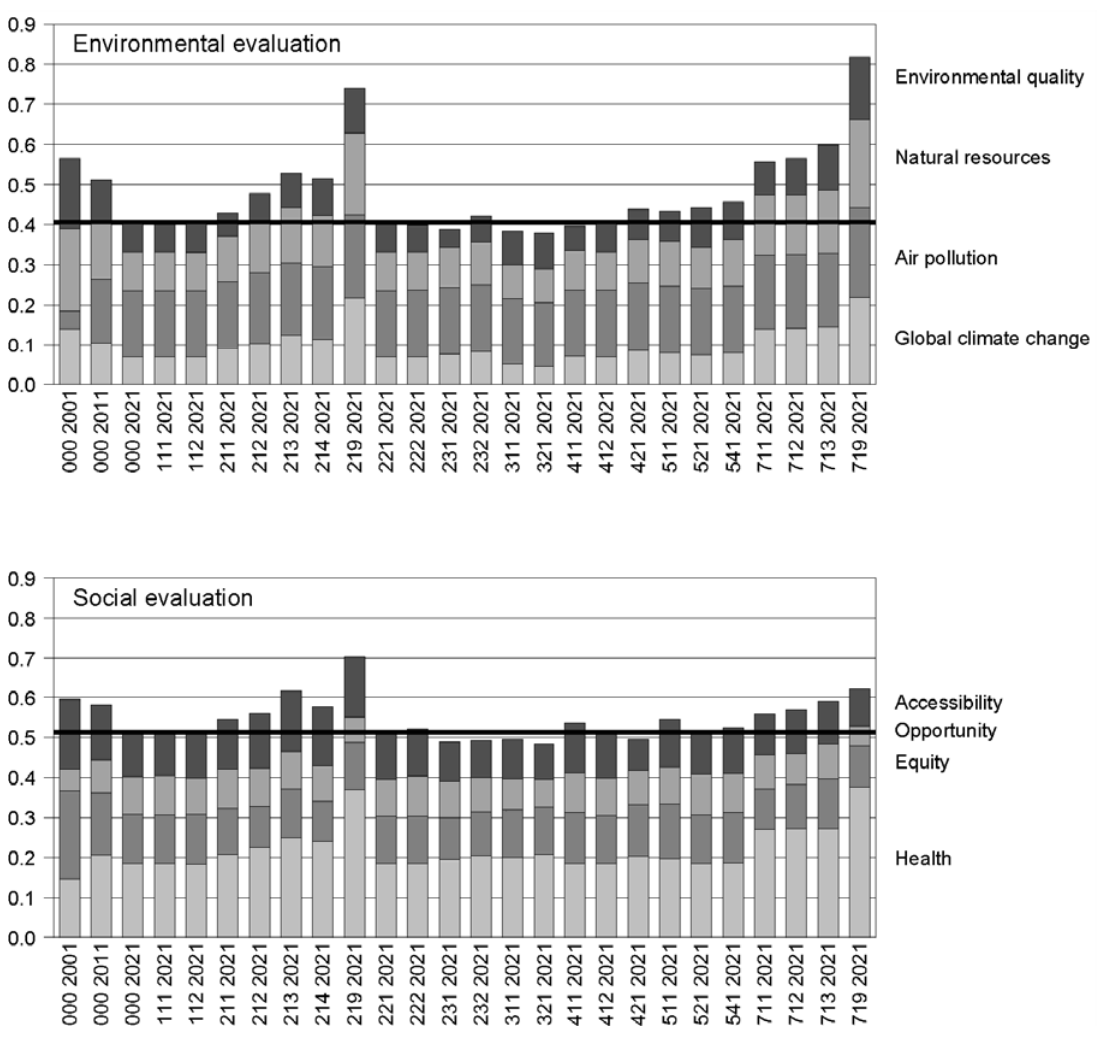
Figure 6. Dortmund policy evaluation: environmental and social indices mixed land use. Scenario 719 scores very high in terms of environment but not equally high in terms of the social index (though still higher than any other scenario except scenario 219 which it includes). As explained earlier, this is due to the accessibility indicator used in the social evaluation, which fails to recognise the benefit of increased mobility in the